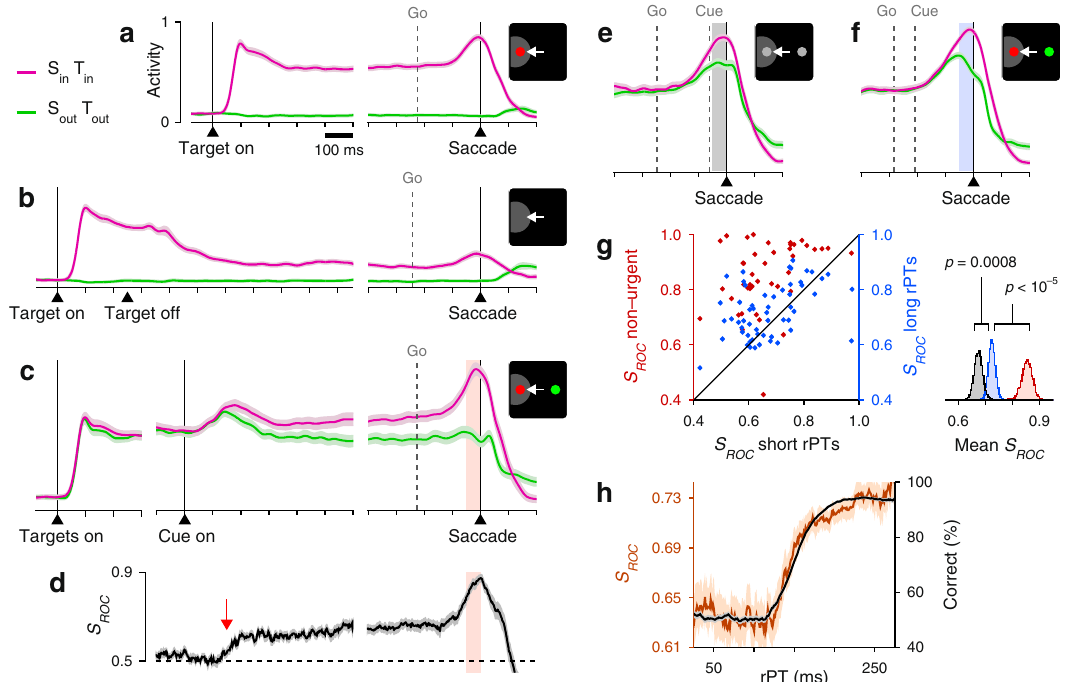
n =43sampledneurons.In d ,arrowisat150ms.In e ,rPT ≤ 125ms.In f ,rPT ≥ 175ms. Source data are provided as a Source Data fi